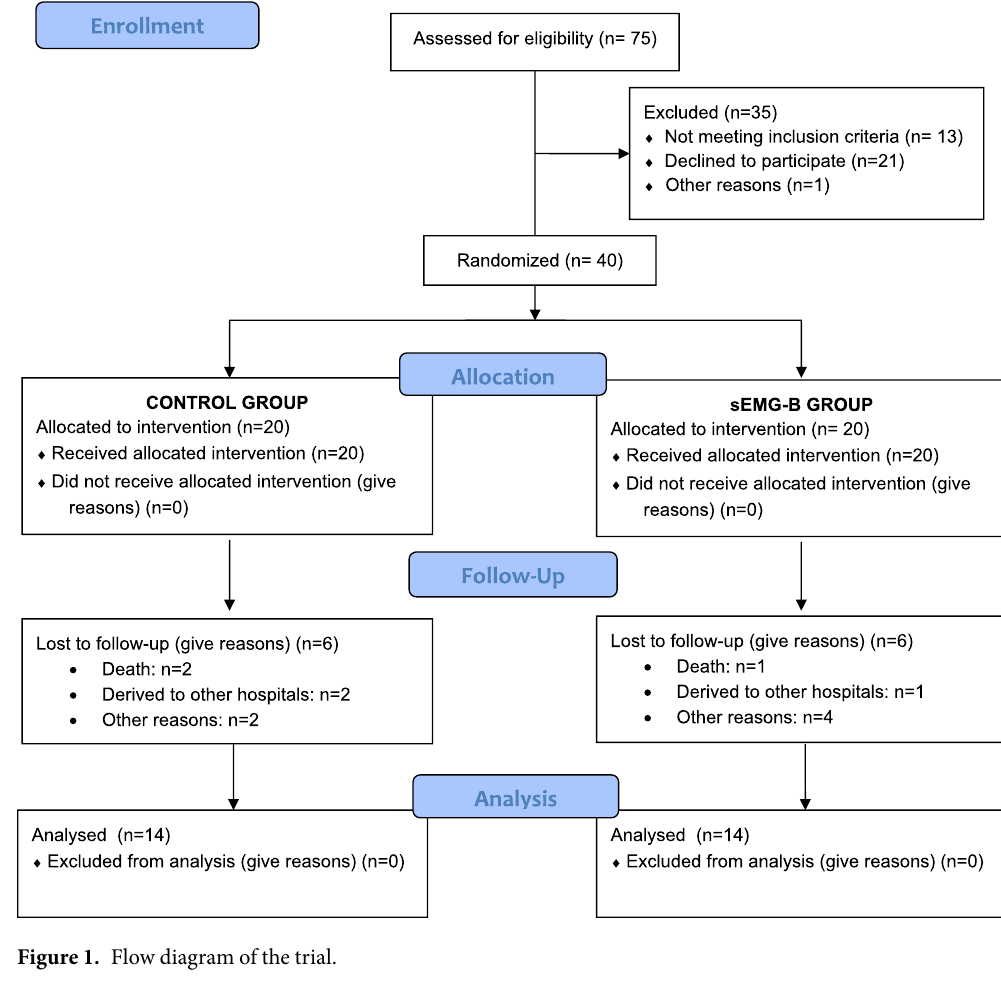
Figure 1. Flow diagram of the